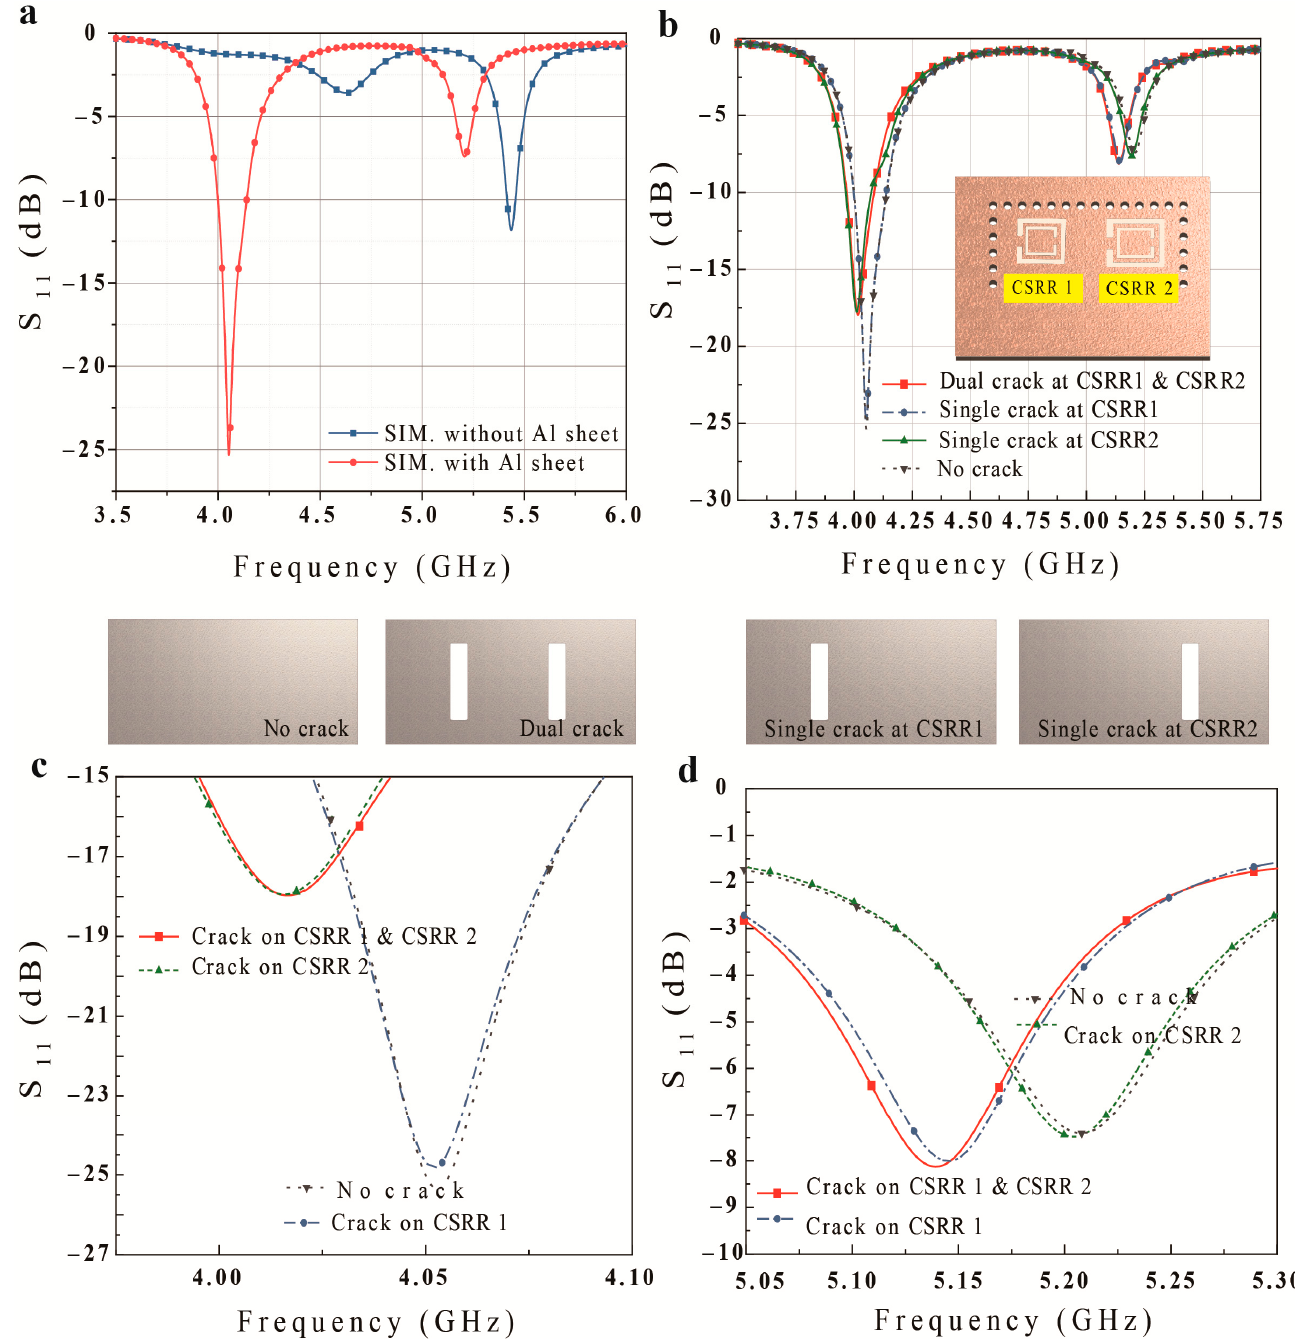
Figure 3. Simulation results for the proposed crack sensor: ( a ) S11 without an Al sheet and with an uncracked Al sheet, ( b ) S11 for different crack numbers and positions (two cracks, single crack at CSRR1, single crack at CSRR2, no crack), S11 results ( c ) in the CSRR2 resonance frequency band, and ( d ) in the CSRR1 resonance frequency band (crack width, depth, and length of 0.5 × 0.5 × 6.1 mm).